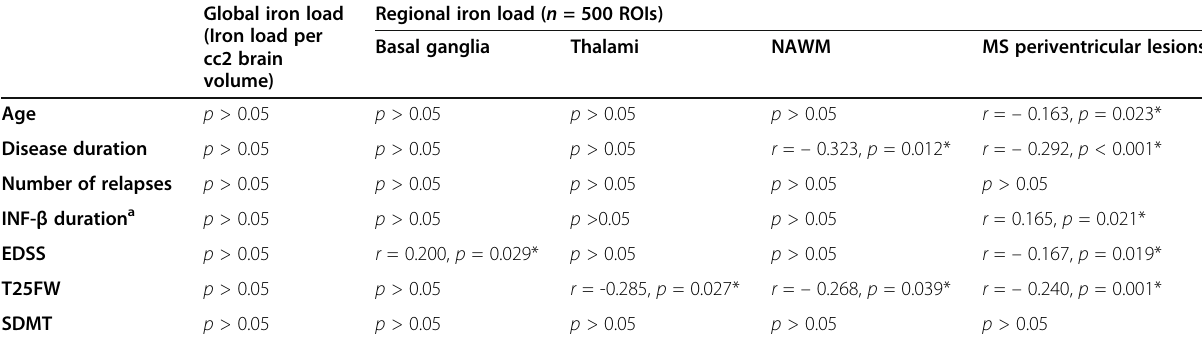
Table 3 Correlation between clinical profile and brain iron concentrations (global and regional) in MS patients Global iron load (Iron load